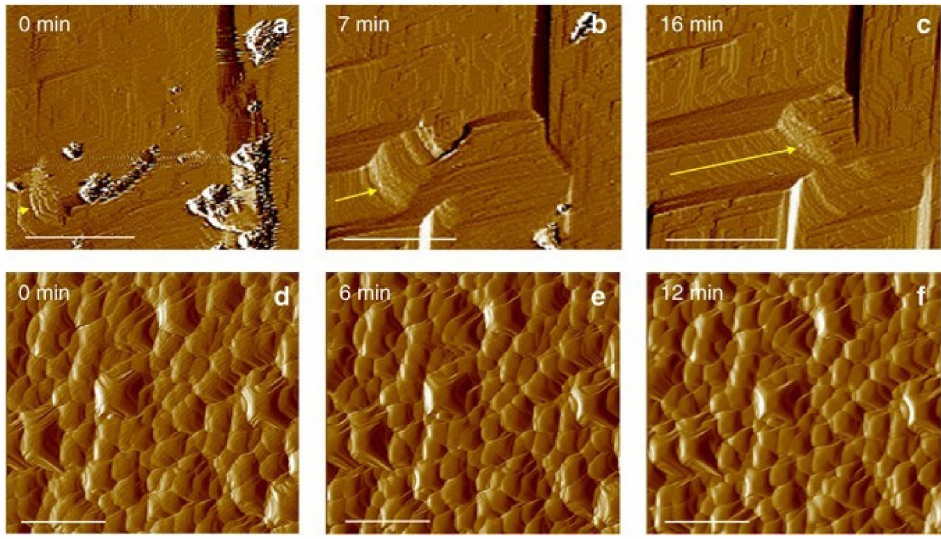
Figure 11. AFM image of the calcite surface over time after exposing the ancient building surface to MgSO4 solution. ( a – c ) Untreated; ( d – f ) Indigenous bacteria-treated [89]. Cheng et al. [91] enriched urease bacteria in soil and added the cementation solution to the soil for in-situ curing experiments. The results showed that in-situ curing does not cause surface blockage on the 1 m-high soil column, but the method of injecting the cementation solution should be constantly optimized in order to achieve deeper